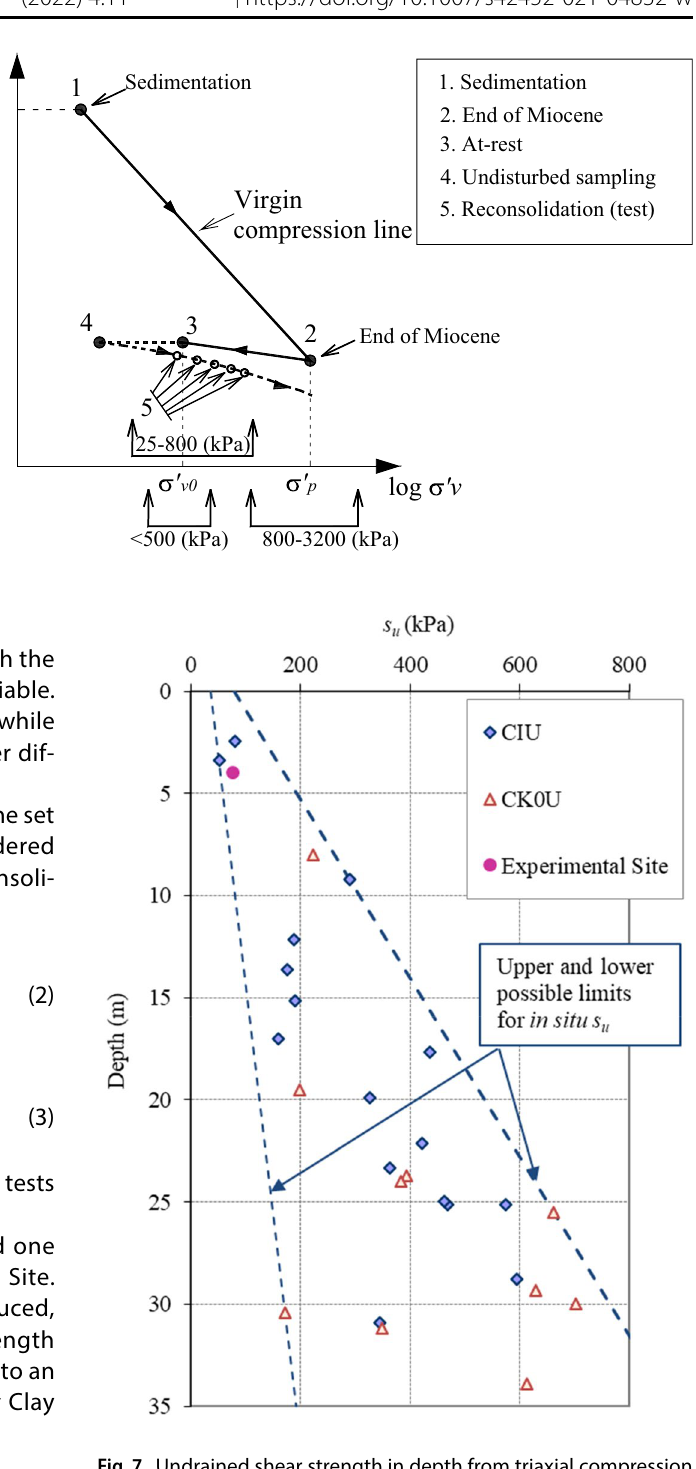
Fig. 7 Undrained shear strength in depth from triaxial compression tests with consolidation stresses close to effective at‑rest